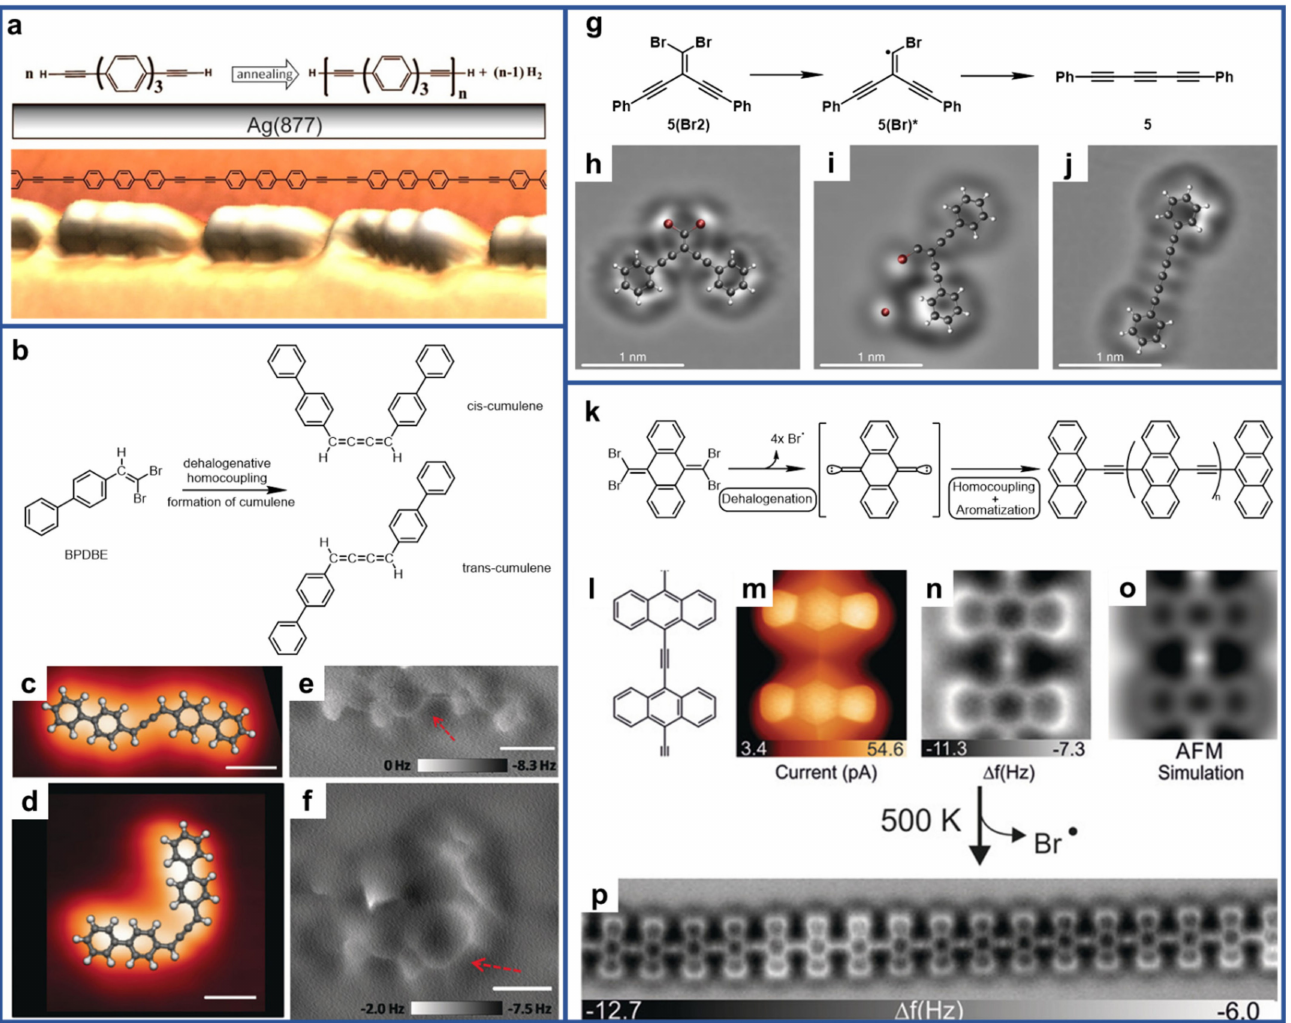
Figure 2. ( a ) Schematic illustration of graphdiyne wires obtained by covalent homocoupling reaction of the 4,4”-diethynyl-1,1 (cid:48) :4 (cid:48) ,1”terphenyl on Ag(877). Reprinted with permission from Ref. [46]. Copyright 2014, American Chemical Society. ( b ) Illustration of the formation of cis - and trans - cumulene products through dehalogenative C–C homocoupling reactions of the 1,1 (cid:48) -biphenyl, 4- (2,2-dibromoethenyl) molecular precursor (BPDBE). ( c , d ) High-resolution STM images of the cis - and trans -cumulene structures together with the equally scaled DFT relaxed models overlaid on top. ( e , f ) Corresponding frequency shift nc-AFM images of the two dimer structures. The red arrows are pointing to the cumulene groups. Scale bars: 5 Å. Reprinted with permission from Ref. [47]. Copyright 2017, Wiley-VCH Verlag GmbH & Co. KGaA, Weinheim. ( g ) The rearrangement reaction of the formation of product 5 from 5(Br2) and one radical intermediate caused by the sequential loss of the two Br atoms. ( h – j ) Laplace-filtered AFM images with structural ball-and-stick models overlaid as a visual aid. Grey, red and white balls represent C, Br, and H, respectively. Reprinted with permission from Ref. [48]. Copyright 2018, Nature Publishing Group. ( k ) Reaction sequence of the TBAn (11,11,12,12-tetrabromoanthraquinodimethane) precursor after deposition on Au(111) and subsequent annealing. ( l ) Chemical structure of an ethynylene-bridged anthracene moiety. ( m ) Constant-height STM, ( n ) nc-AFM and ( o ) nc-AFM simulation image. ( p ) Constant-height nc- AFM image of a linear ethynylene-linked anthracene polymer after annealing to 500 K. Reprinted with permission from Ref. [49]. Copyright 2019, Wiley-VCH Verlag GmbH & Co.